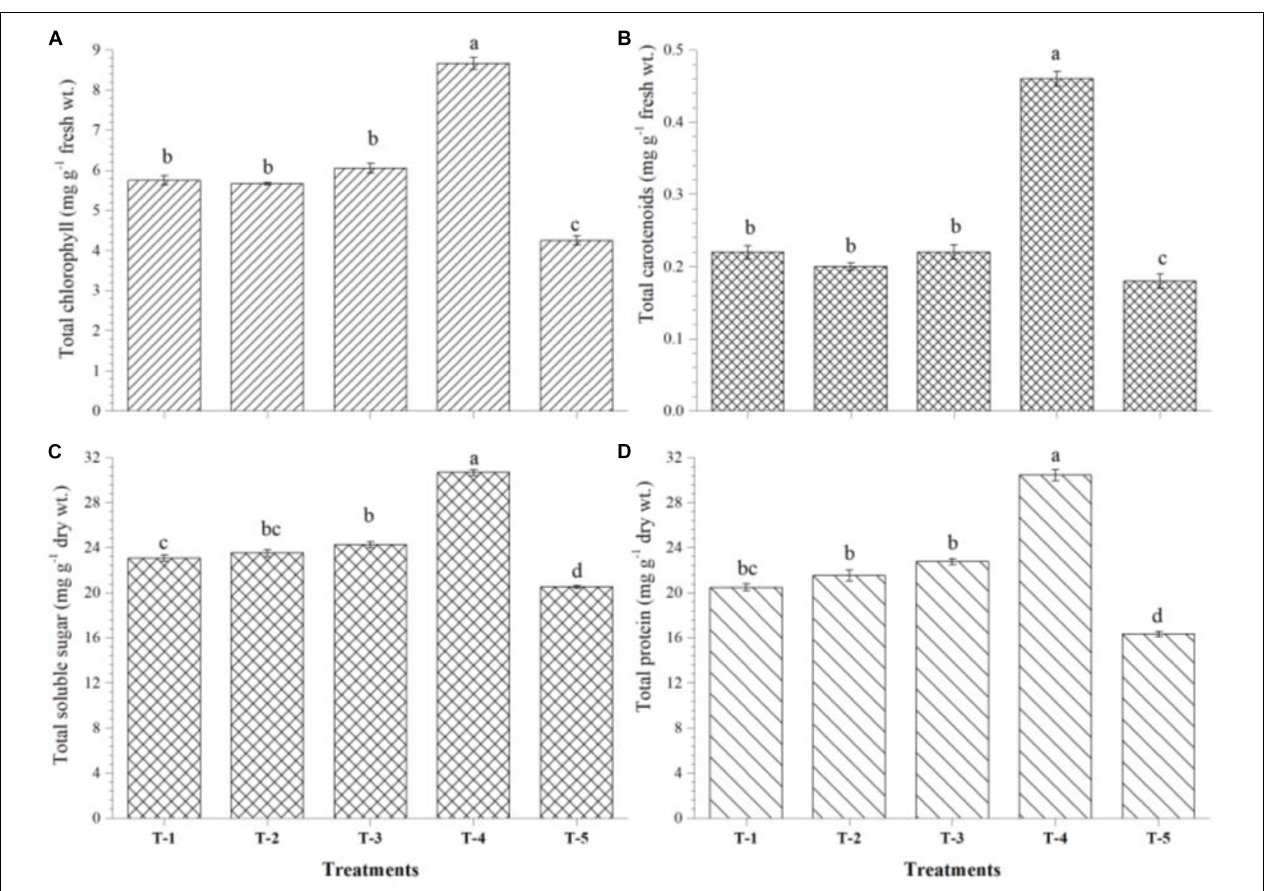
FIGURE 4 | Effects of seed bio-inoculation on activities and accumulation of (A) total chlorophyll, (B) total carotenoids, (C) total soluble sugar, and (D) total protein in the maize leaves grown in saline sodic soil at 45 days of sowing. Treatments were as follows: T 1 — B. safensis MF-01, T 2 — B. altitudinis MF-15, T 3 — B. velezensis MF-08, T 4 — B. safensis MF-01 + B. velezensis MF-08 + B. altitudinis MF-15, and T 5 —control (untreated). Data are mean ( n = 10) and vertical bar represents standard deviation. Data with different letters show significant difference in column data in randomized block design test at p < 0.05 under Duncan’s multiple range